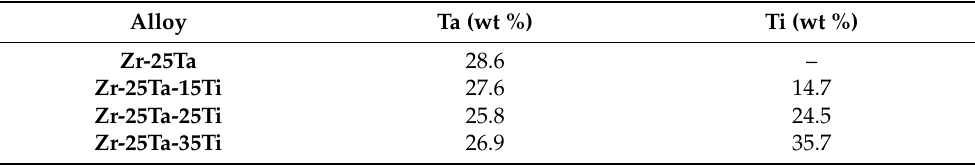
Table 3. Quantitative chemical analysis of the produced Zr-25Ta-xTi alloys using